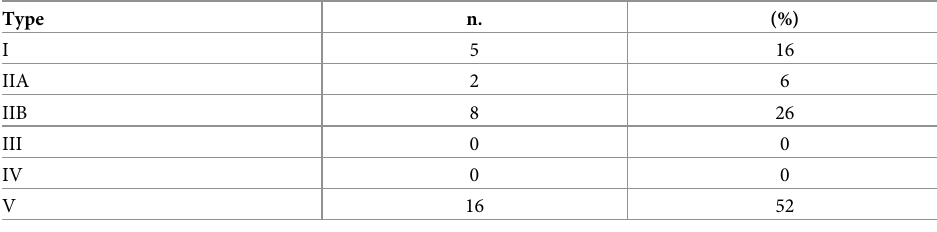
Table 4. Angiographic type (n = 31).